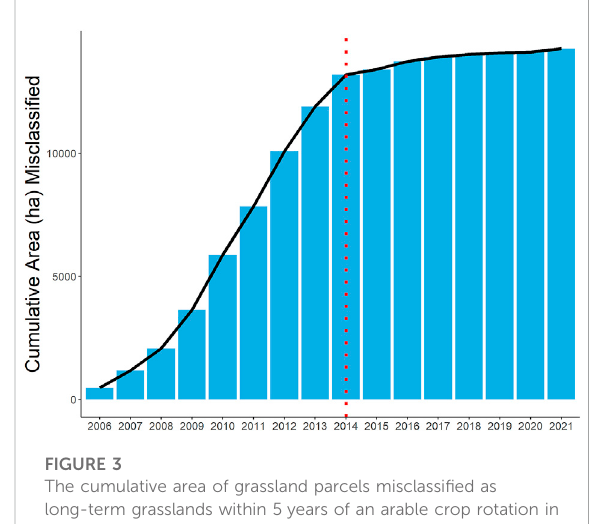
FIGURE 3 The cumulative area of grassland parcels misclassi fi ed as long-term grasslands within 5 years of an arable crop rotation in southwestFriesland,NL.93%ofmisclassi fi cationsoccurredbefore the vertical red line between 2006 and 2014.